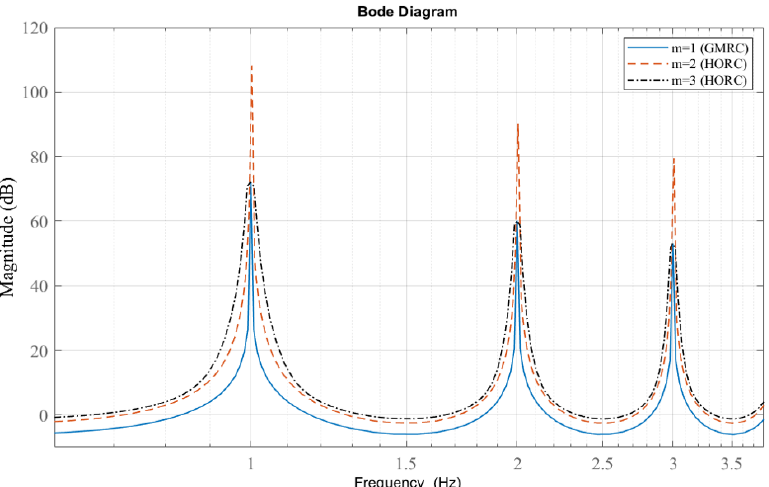
Figure 1. Magnitude responses of the GMRC and the